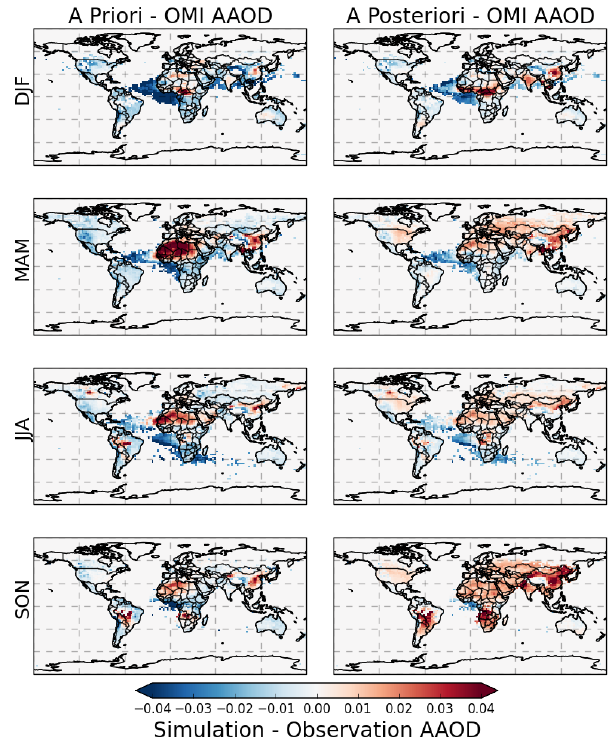
Figure 12. Differences between a priori and a posteriori GEOS- Chem seasonal AAOD with OMI/OMAERUV products.